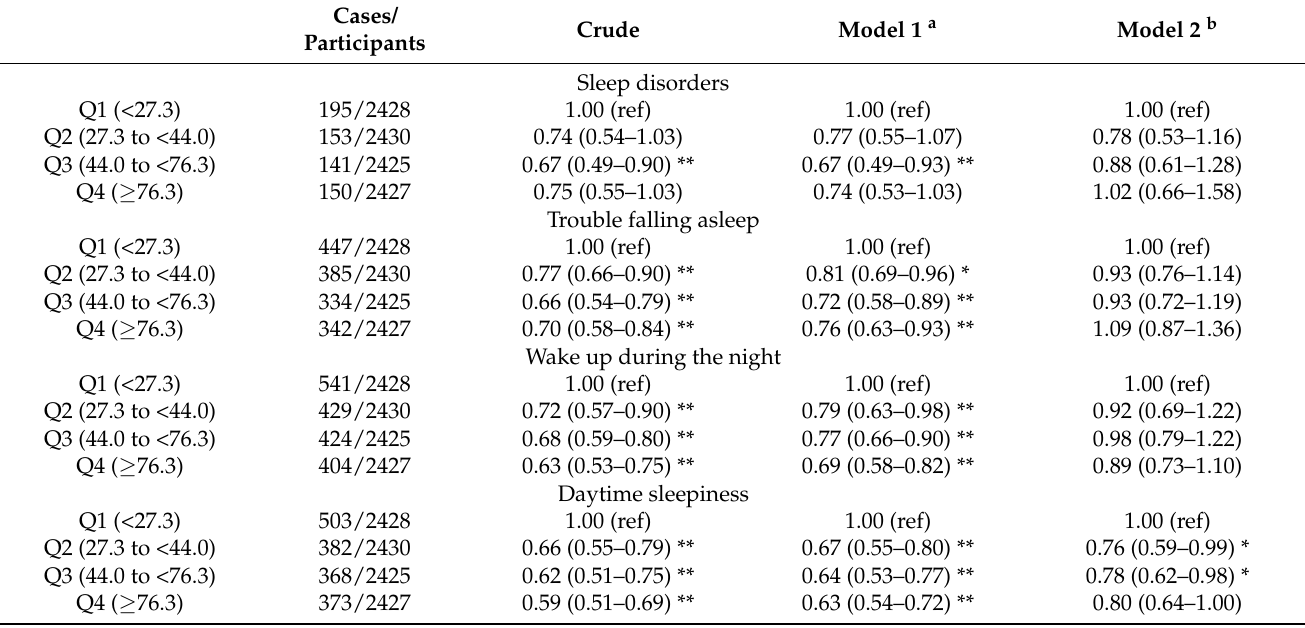
Table 2. Weighted odds ratios (95% confidence intervals) for sleep disorders across quartiles of